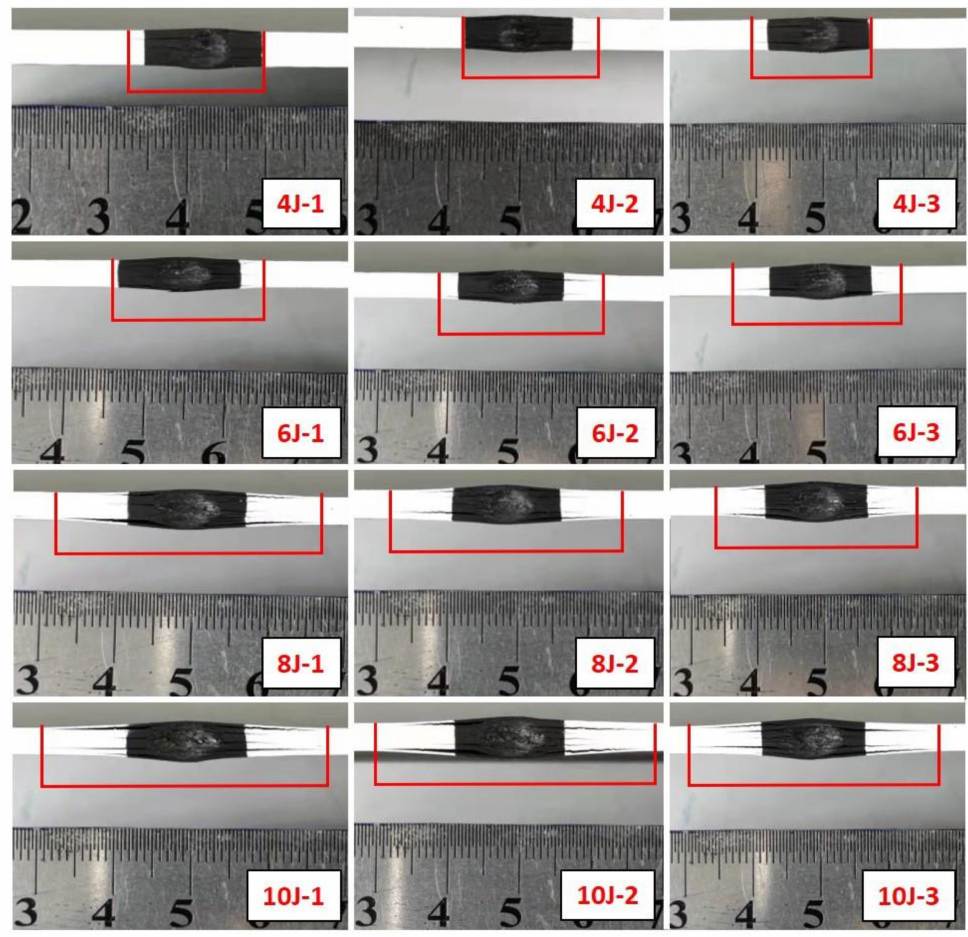
Figure 8. Surface damage of laminates.